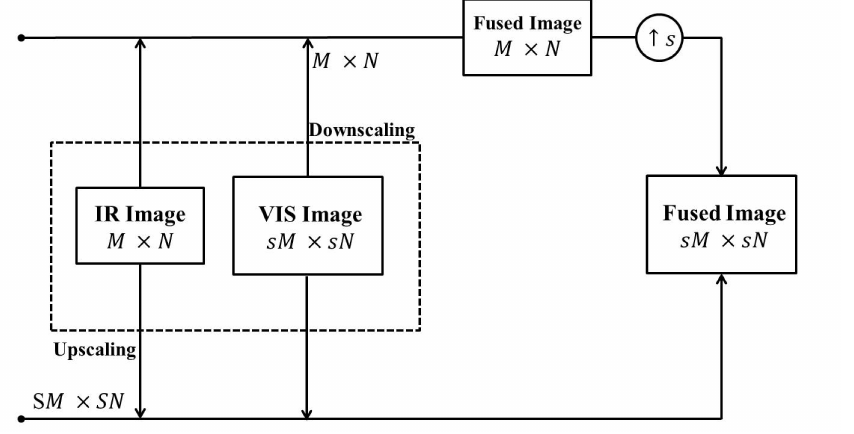
Figure 1. Different resolution IR-VIS image